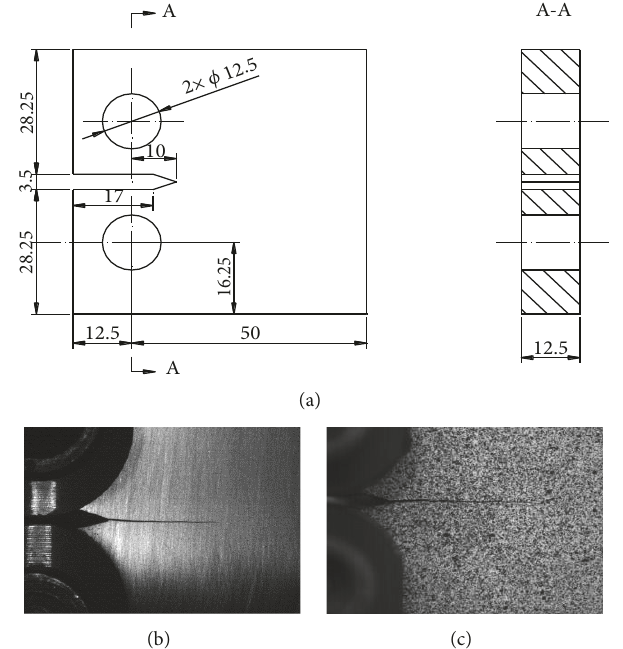
Figure 3: (a) Geometry of CT specimen. (b) Crack image of CT specimen. (c) Digital speckle image of CT specimen.